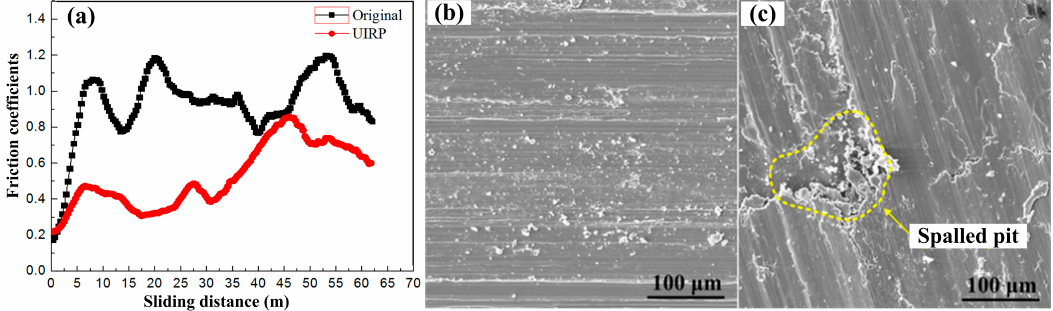
Figure 8. Friction coefficients and worn morphologies obtained at 250 r/min after 300 cycles. ( a ) Friction coefficients; ( b ) worn morphology of UIRP sample; ( c ) worn morphology of original sample.